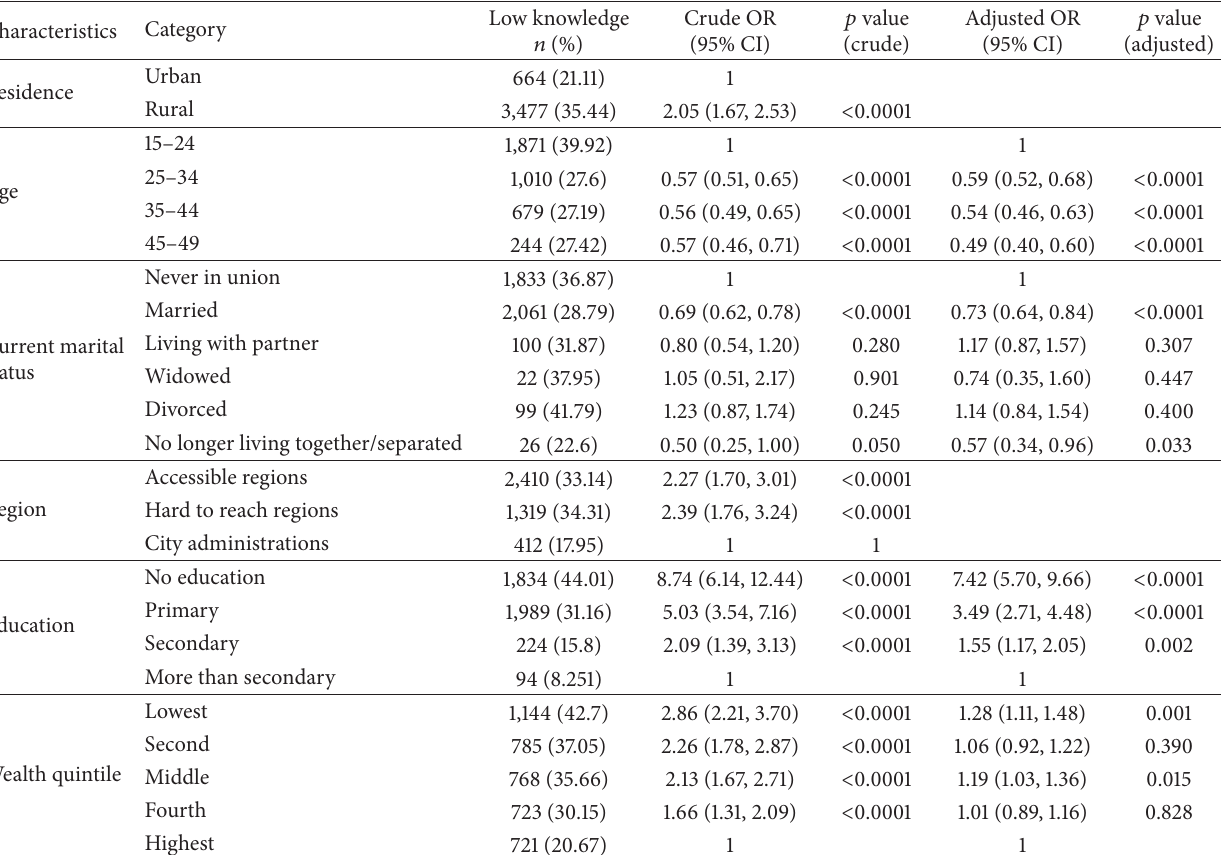
Table 6: Factors associated with low TB knowledge among men, Ethiopia